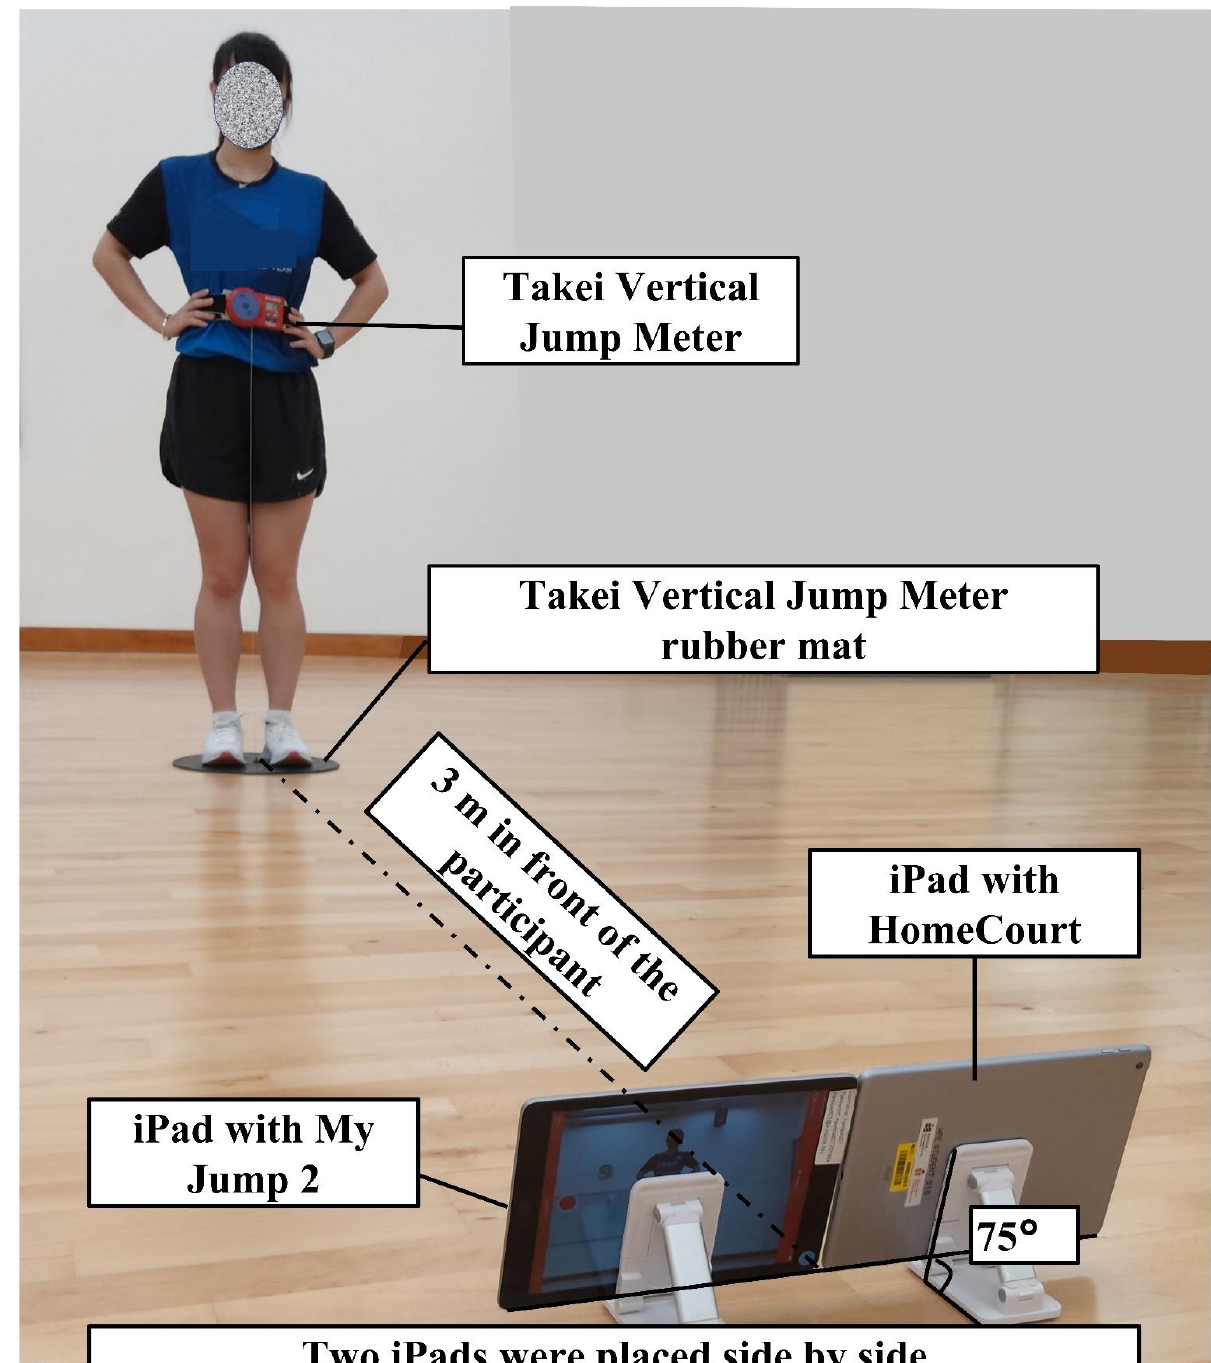
Figure 2. Measurements placement for the CMJ reliability